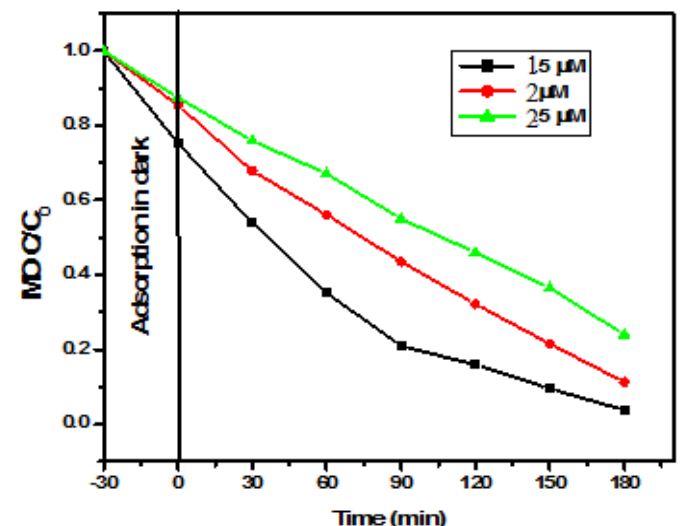
Fig. 9. Effect of concentration of MO and its